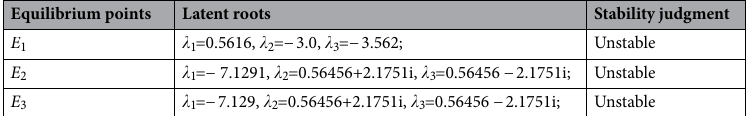
Table 2. Equilibrium points and stability of the system.